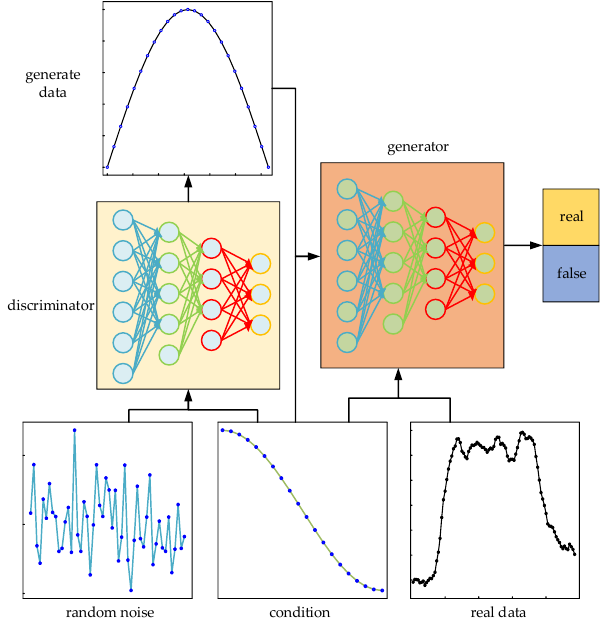
Figure 1. Basic structure of CGAN.